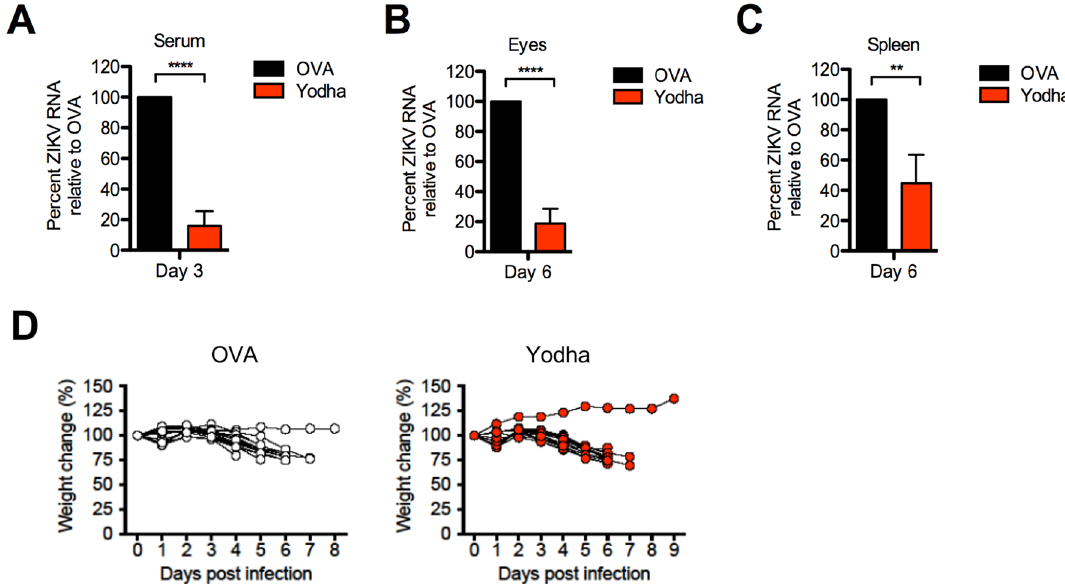
Figure 6. Administration of Yodha peptide reduces ZIKV viremia and viral burden in mice. Briefly, cohorts of 4–5-week-old mice were given 2 mg anti-Ifnar1 mAb intraperitoneally, and the following day infected with 10 5 FFUs of PRVABC ZIKV. Viremia and viral burden were monitored in serum and tissues by real time PCR. Viremia in the serum at days 3 post-infection ( A ) samples and viral burden at day 6 in the eye ( B ) and spleen ( C ) are shown. All qRT-PCR data is represented as a relative percentage as compared to the average of the OVA controls, calculated as: percent ZIKV RNA relative to OVA = ([Yodha ZIKV RNA ] / [Average OVA ZIKV RNA ]) * 100. ( D ) Cohorts of 5–6-week-old IFNAR KO mice were infected with 10 2 FFUs of ZIKV MR766. Body weights were measured daily and the changes for OVA- and Yodha-treated groups are displayed. Statistical significance was assessed by unpaired t- test; two-tailed ( A , Left) p < 0.0001 **** ( A , Right) p = 0.0125 *, ( B ) p < 0.0001 **** ( C ) p = 0.0088